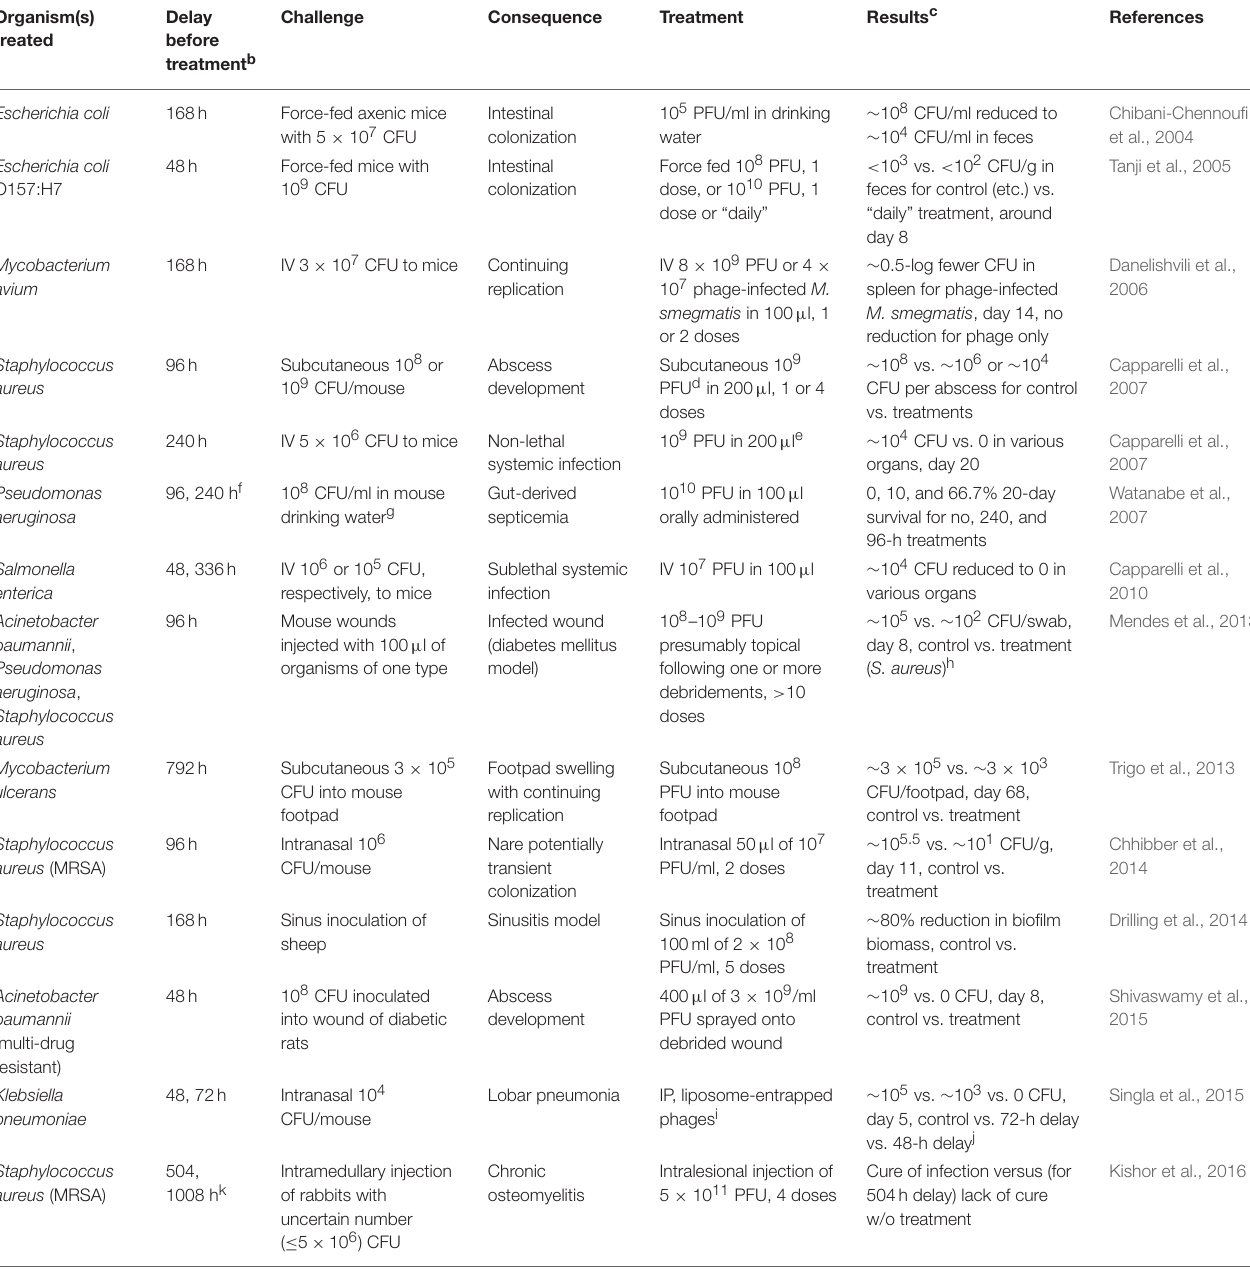
TABLE 1 | Animal models of human phage therapy with treatment delays exceeding 24h. a